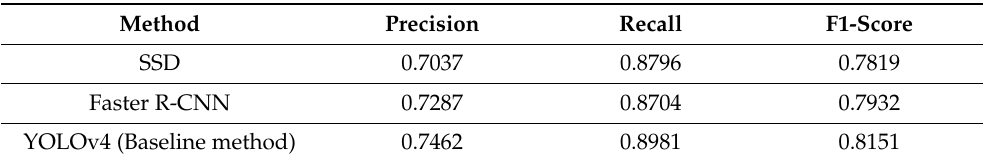
Table 3. Comparison of the baseline method (YOLOv4) with the SSD model and Faster R-CNN model on the test dataset of the proposed method.